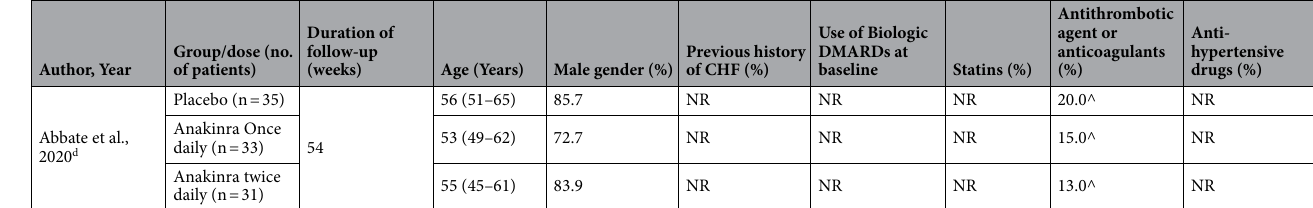
Table 1. Baseline patient characteristics. NR, Not reported; CHF, Congestive Heart Failure. *, Angiotensin converting enzyme inhibitors; **, Renin angiotensin system inhibitors; ^, Clopidogrel. a Study was designed as two independent clinical trials. Placebo and BIW data were pooled together for analysis. b Study characteristics data taken from another published article mentioned in clinical trials database. d Age is reported as median